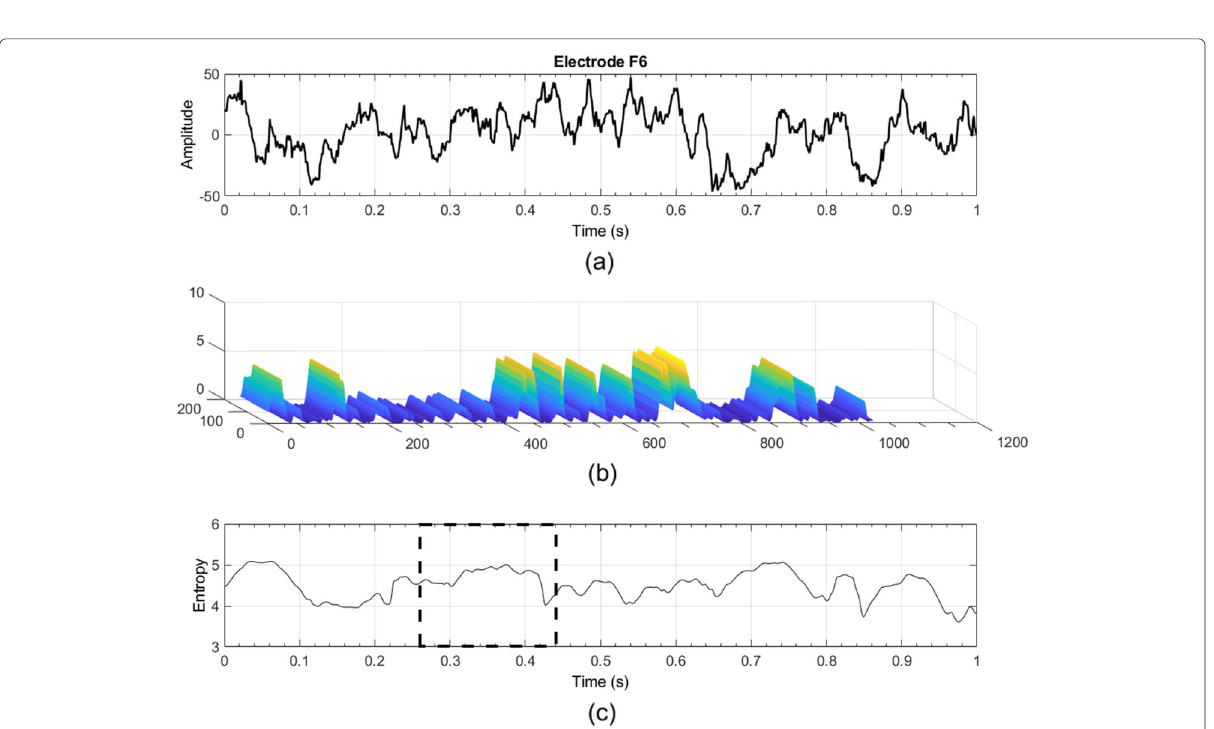
Fig. 20 Electrode F6 after RICI. a Time domain representation of ERP. b SPWVD time-frequency representation. c Short-term Rényi entropy of the